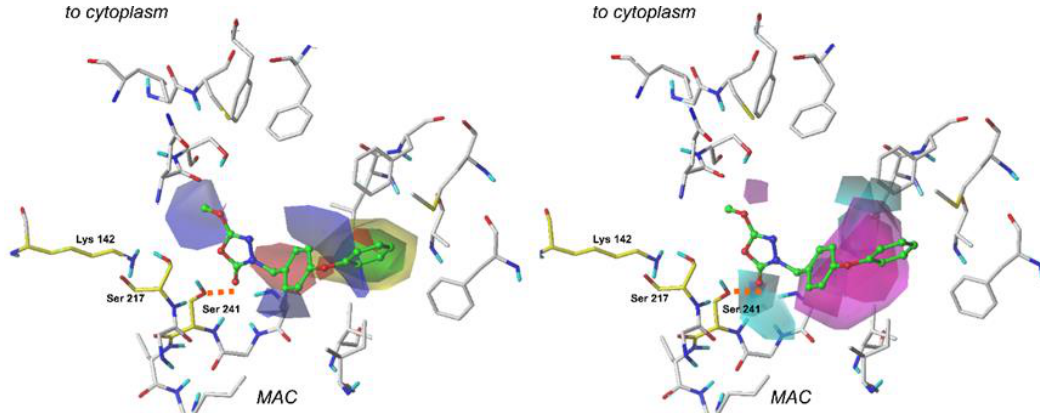
Figure 6. Comparative Molecular Similarity Indices Analysis (CoMSIA) steric, electrostatic (left), H-bond acceptor and H- bond donor (right) fields projected on the 3D-structure of fatty acid amide hydrolase in complex with the least active compound ( 31 ). Fields are drawn with 60/40, 70/30, 60/40, 60/40 proportions, respectively. Ligands are shown as sticks and balls with green carbon atoms. Protein is shown as wires with gray carbon atoms. Catalytic residues are presented as sticks and colored using yellow carbon atoms. A bond formed between a ligand and an enzyme is depicted as an orange dashed line. Non-polar hydrogens are omitted for clarity.